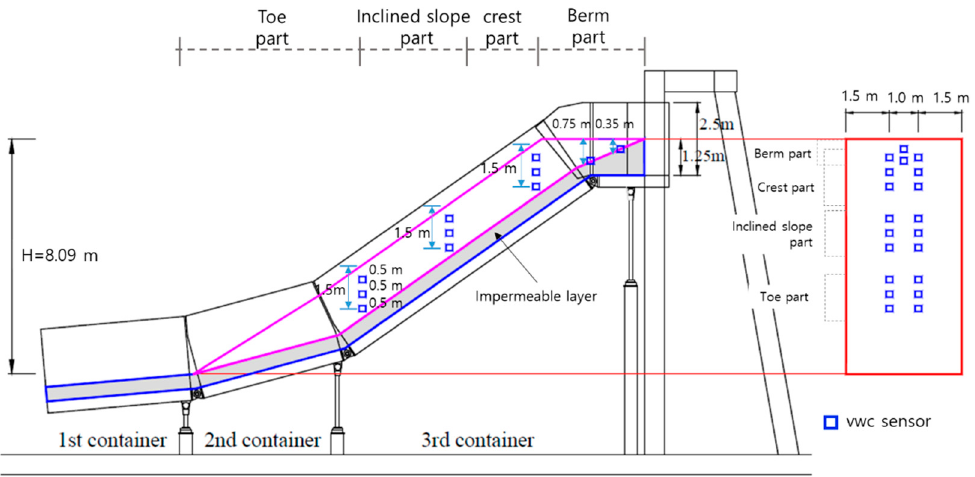
Figure 12. Schematic representation of full-scale flume experiment set up with soil profiles.